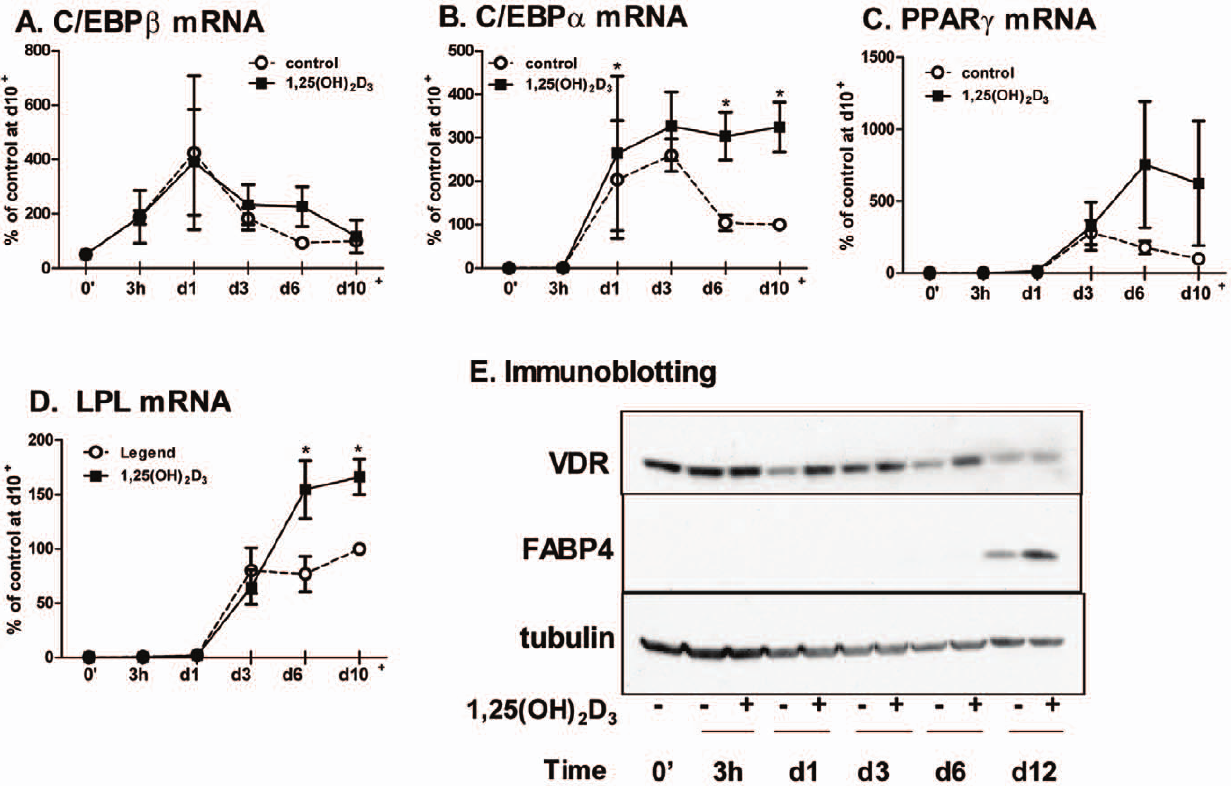
Figure 4. Time-course effects of 1,25(OH) 2 D 3 on adipogenic marker expression. Human preadipocytes were differentiated in the absence or presence of 1,25(OH) 2 D 3 (10 2 8 M, added continuously throughout). Expression levels of adipogenic markers [C/EBP b (A), C/EBP a (B), PPAR c (C), and LPL (D)] were measured before (0 9 ) and at indicated time points during differentiation. Data are presented as % of vehicle control after differentiation (d10–12; d10 + ) in each experiment. *, p , 0.05, vehicle control vs. 1,25(OH) 2 D 3 treatment, n=4. E. Representative FABP4 and VDR blots from 3 independent experiments are presented.